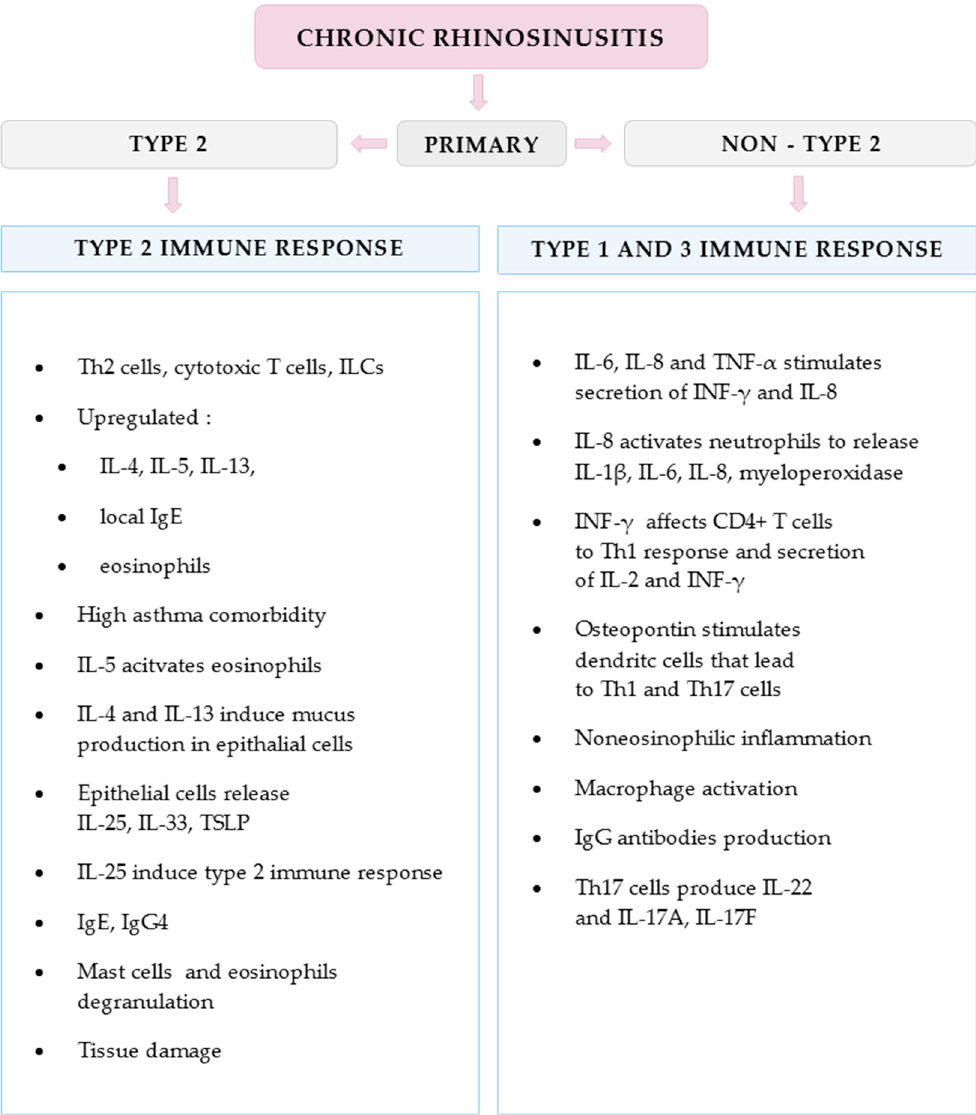
Figure 2. Selected immune activity mechanisms involved in type 2 and non-type 2 immune response in case of chronic rhinosinusitis described by Grayson et al. ([18], modified).